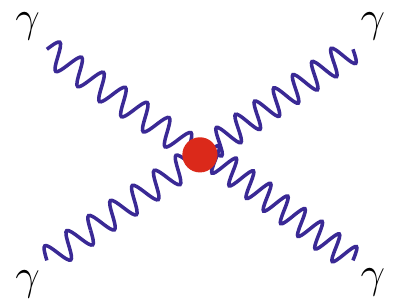
Fig. 1 The diphoton production in the collision of the backscattered photons at the CLIC via anomalous quartic coupling